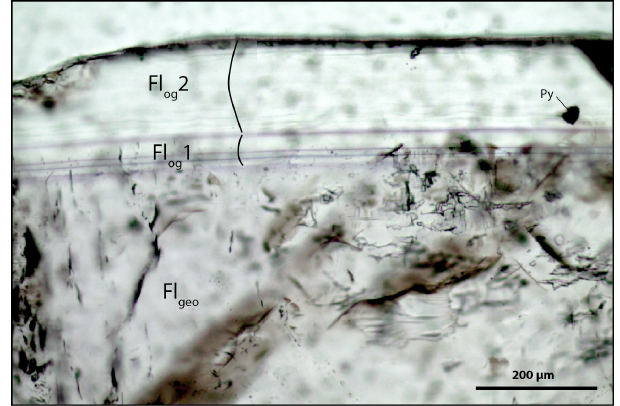
Figure A4. Microphotography of the fluorite stages from the Pierre- Perthuis ore showing the contrast in fluid inclusion concentrations between Fl geo and Fl og . Py: pyrite.